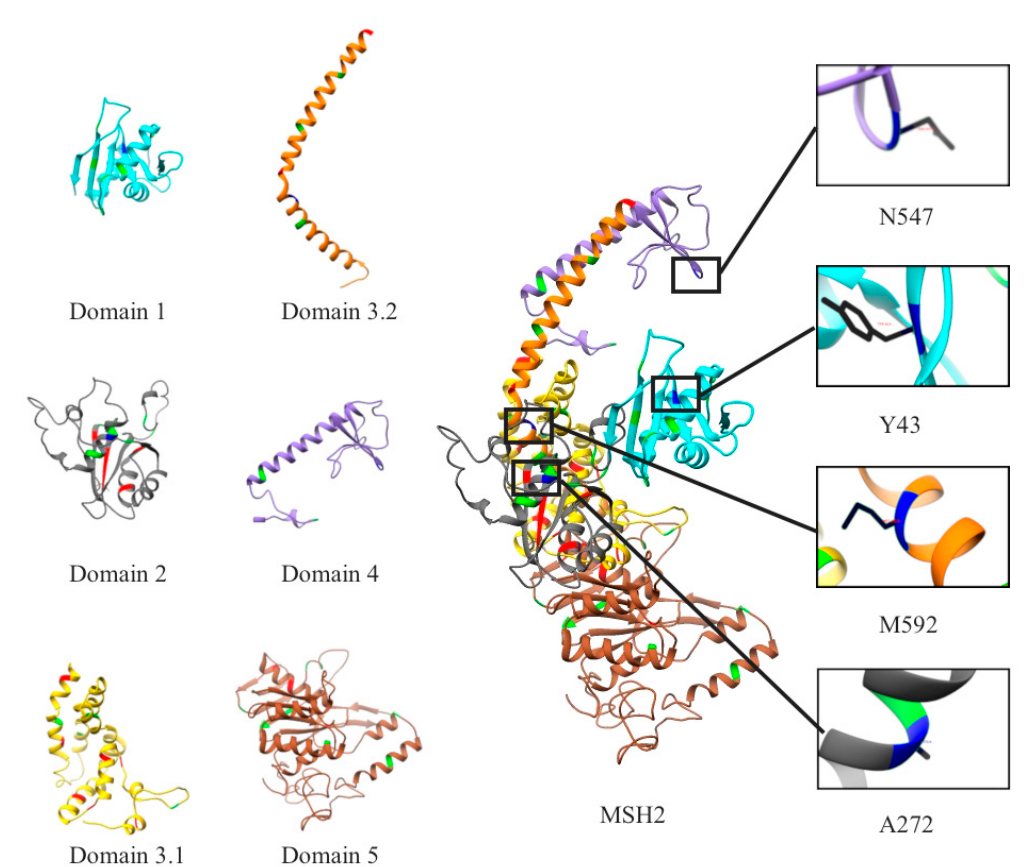
Figure 1. The 3D Structure of the MSH2 Protein. Each domain is depicted in a different color: Domain 1(cyan) mismatch binding domain, domain 2 (dark gray) connector, domain 3.1 (yellow) levers, domain 3.1 (orange) levers, domain 4 (purple) clamps, and domain 5 (sienna) ATPase domain. Differentiation among the mutations is depicted with pathogenic in red, non-pathogenic in green and unknown significance (VUS) in blue.